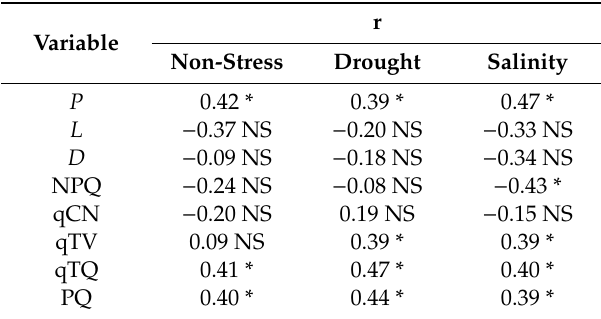
Table 5. Correlation coe ffi cients (r) between grain yield and di ff erent fluorescence quenching parameters in response to the potentially beneficial bacterial ( N =